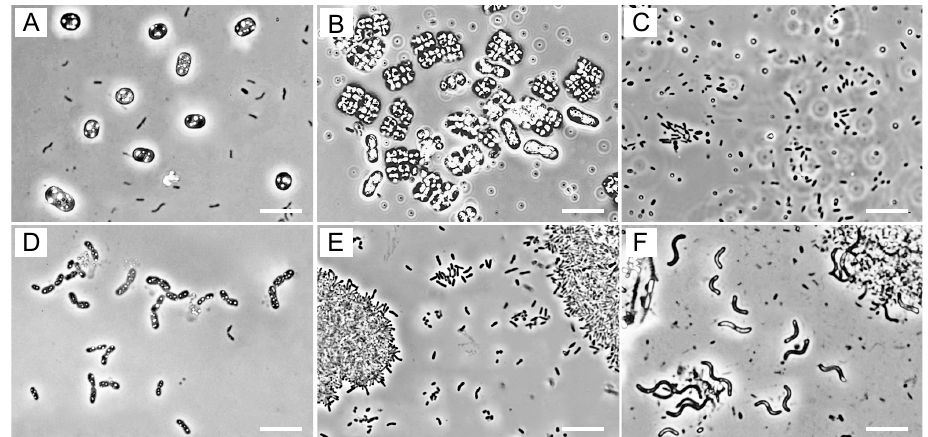
Figure 1. Phase-contrast micrographs of microorganisms in the colored blooms and mats. ( A ) Hot spring mat H1; ( B ) mudflat Y1; ( C ) tide pool J1; ( D ) tide pool J2; ( E ) swine wastewater ditch D1; ( F ) sewage ditch D3. Scale bars = 10 µm.